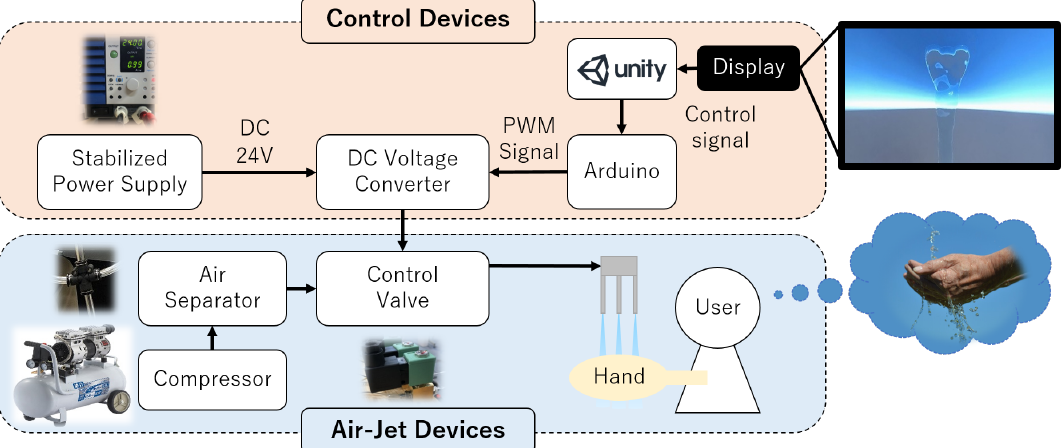
Figure 5. System